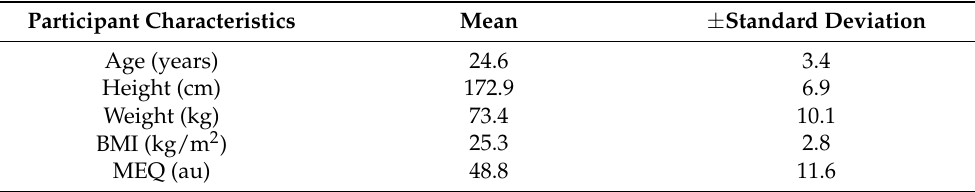
Table 2. Results of multiple linear regression models for absolute and relative changes in heart rate variability parameters.